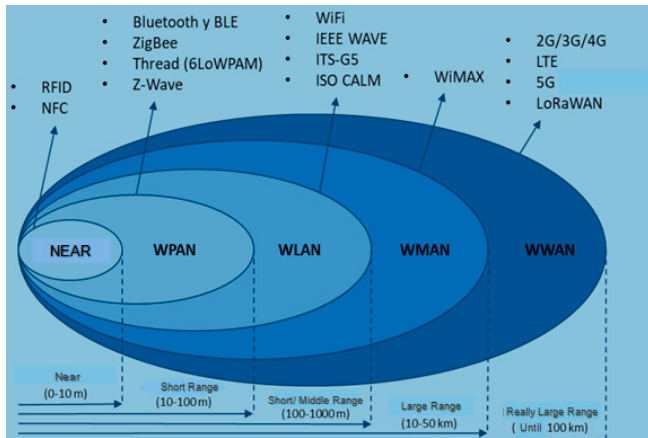
Figure 3. Communication technologies .